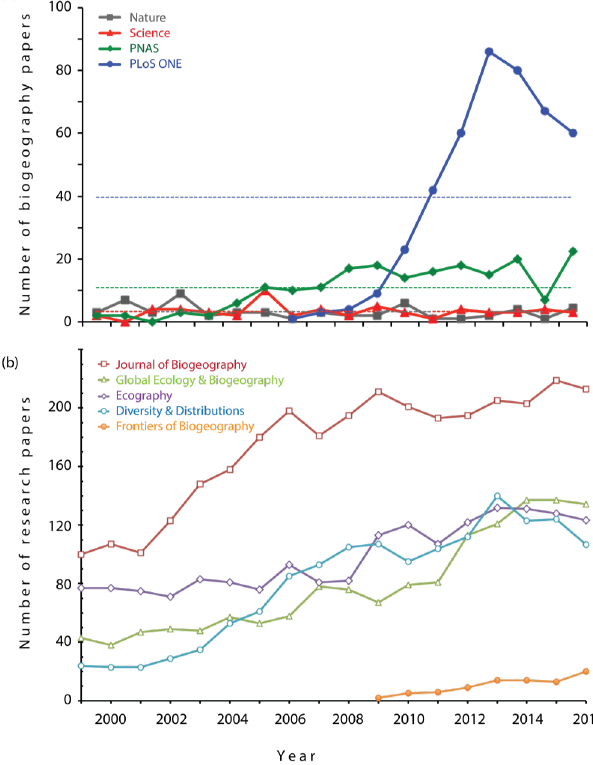
Figure 2. Publishing trends in biogeography. (a) Number of biogeography papers published in four of the most recog- nized “multidisciplinary sciences” publications, as catego- rized by Thomson Reuters, annually since 1999, per the Web of Knowledge database (solid lines). Horizontal dashed lines show the long-term mean number of articles per year per journal for the 17-year period analyzed. Articles were identified by the topic word search “biogeography” in the Science Citations Index–Expanded; figure updated from Dawson et al. (2016) in January 2017. (b) Number of articles published since 1999 in five journals with emphases in bio- geographic research. A sixth journal, Molecular Phylogenet- ics & Evolution , shows a trend for articles on phylogenetic (historical) biogeography that largely overlays the overall trend for Journal of Biogeography (data not